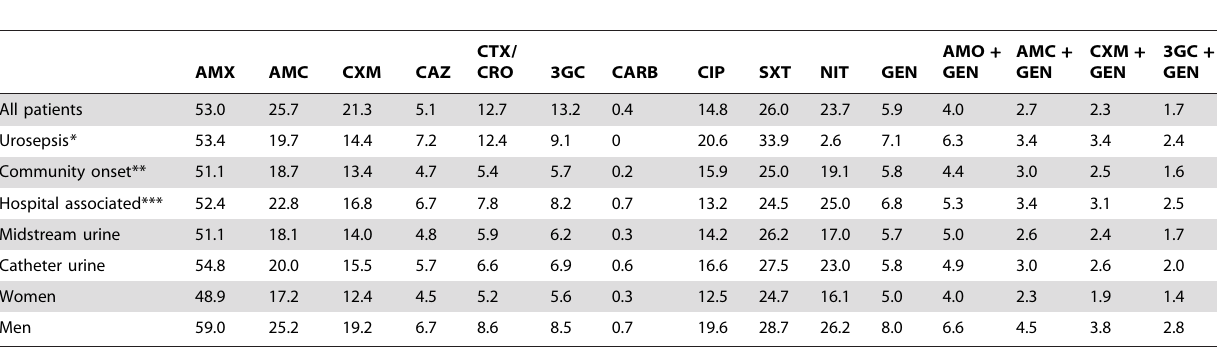
Table 2. The probability of inadequate coverage (e.g., weighted average) for gram-negative uropathogens (see table 1) in different groups of patients or urinary specimen types, ISIS-AR, the Netherlands 2012.